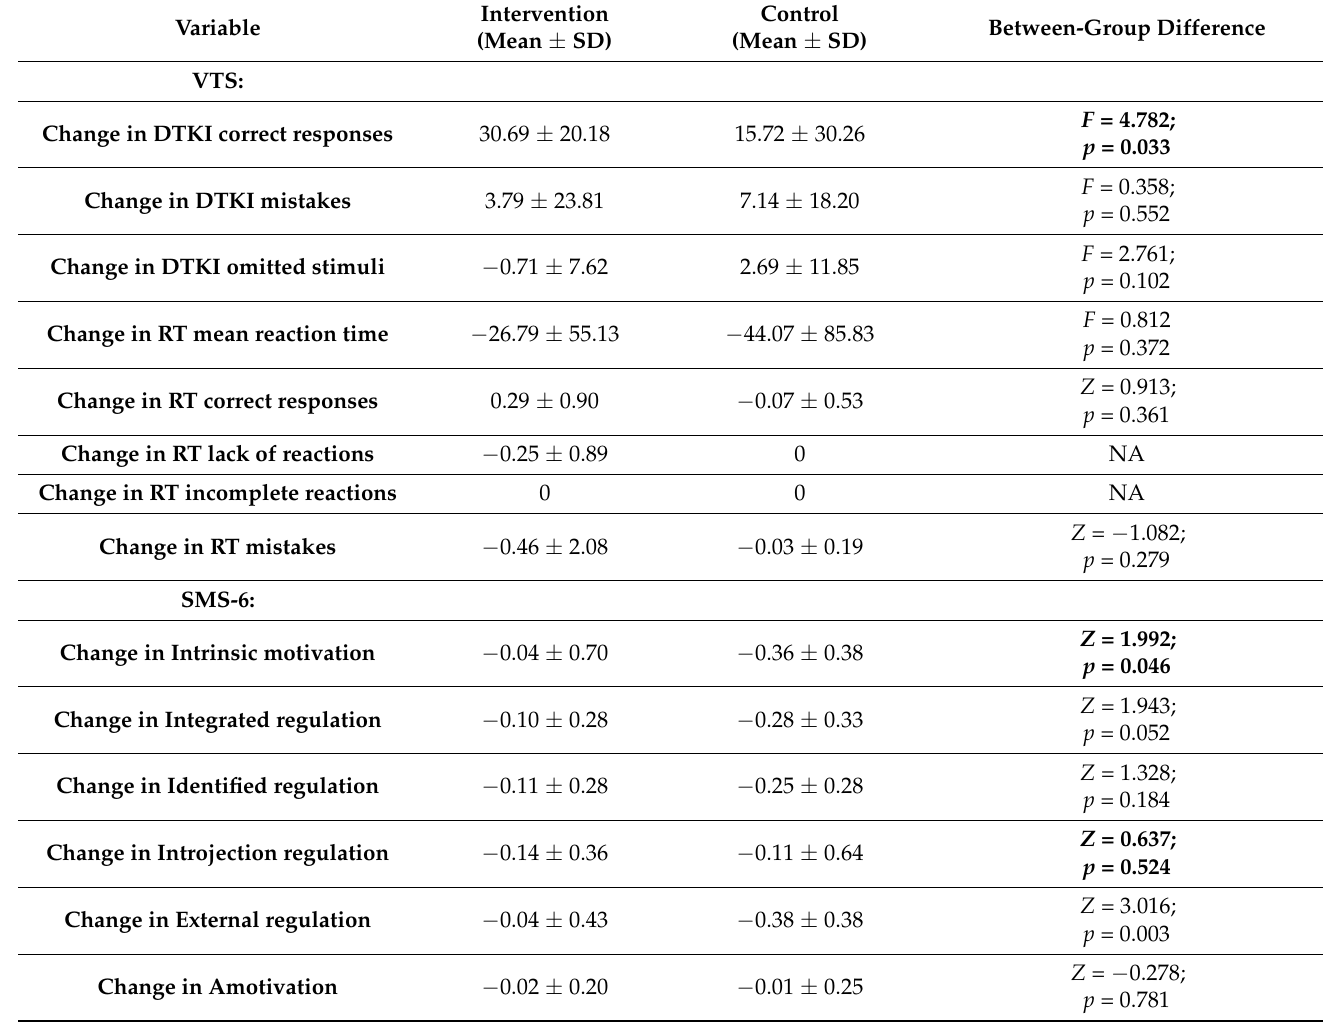
Table 3. The differences in the change of VTS scores in time between intervention and control